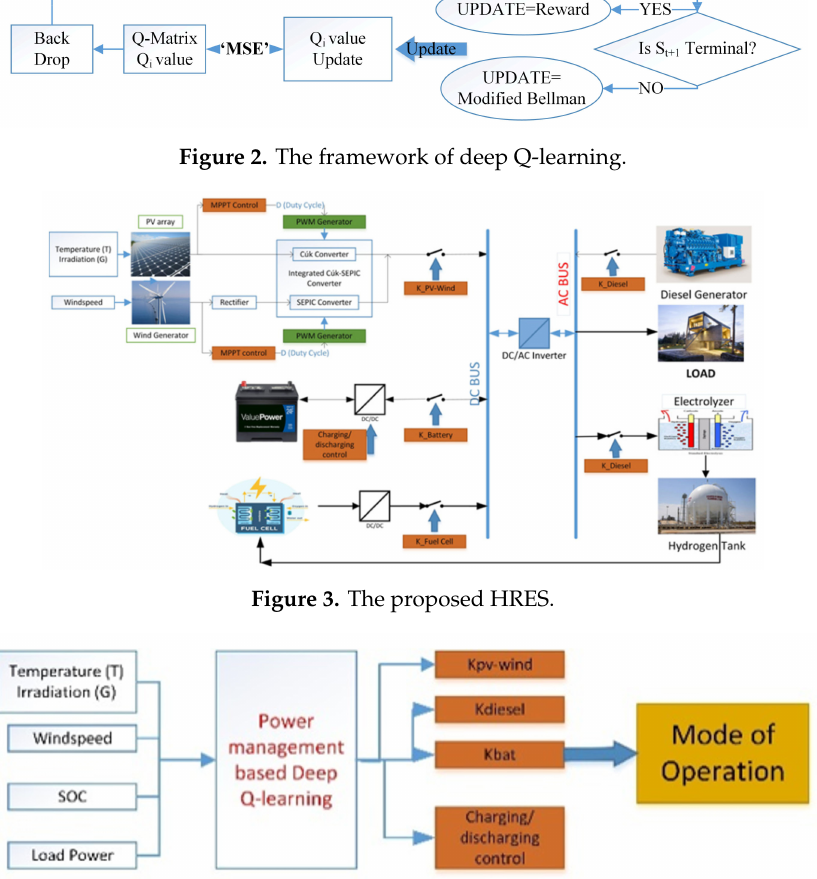
Figure 4. EMS based on Deep Q-learning of a hybrid renewable energy system